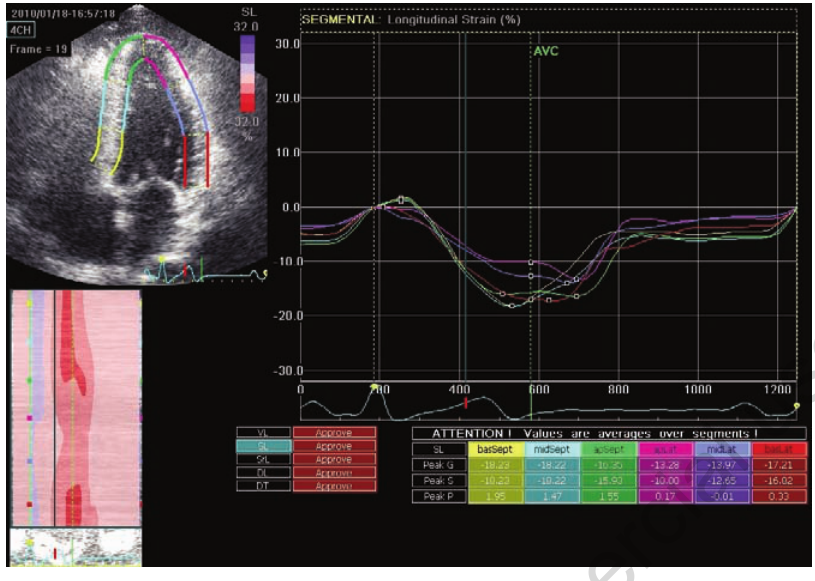
used.Figure 1. A case of Fabry disease showing uniformly reduced values of 2D longitudinal peak systolic strain; interestingly the segments of the lateral wall show the double peak